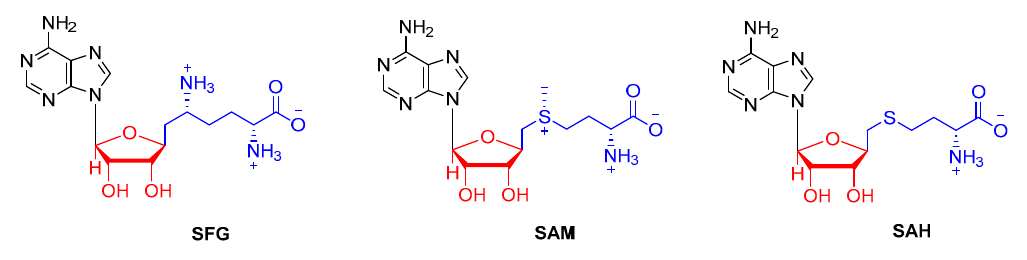
Figure 2. Chemical structures of SFG, SAM and SAH.